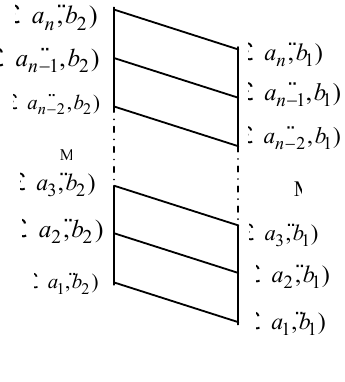
Figure 1. Hasse Diagram of